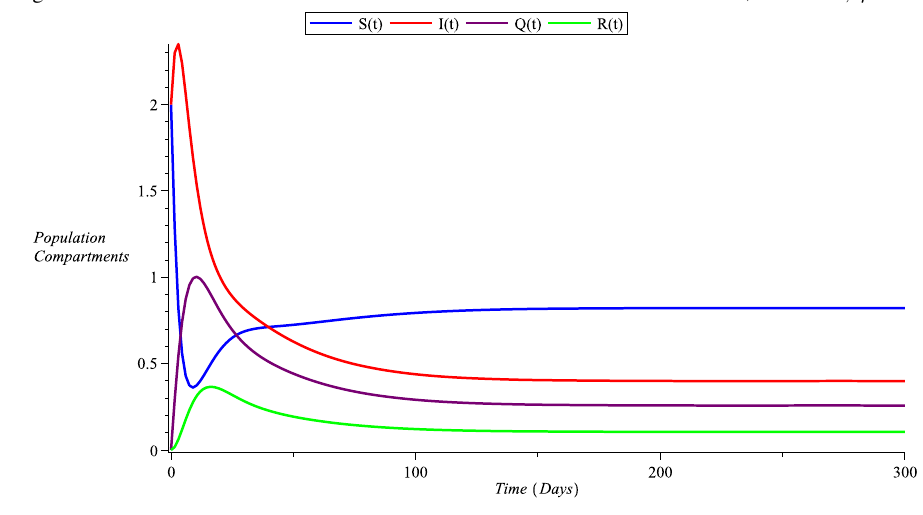
Fig. 4. Time-course solution with relaxed lockdown and strict social isolation, σ = 0 . 70 , η = 0 . 1 .